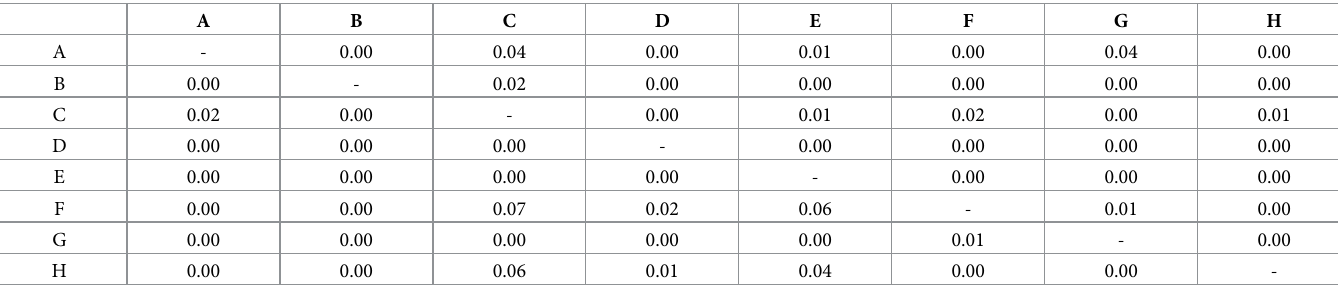
Table 2. Pairwise genetic differentiation between putative populations for the mtDNA control